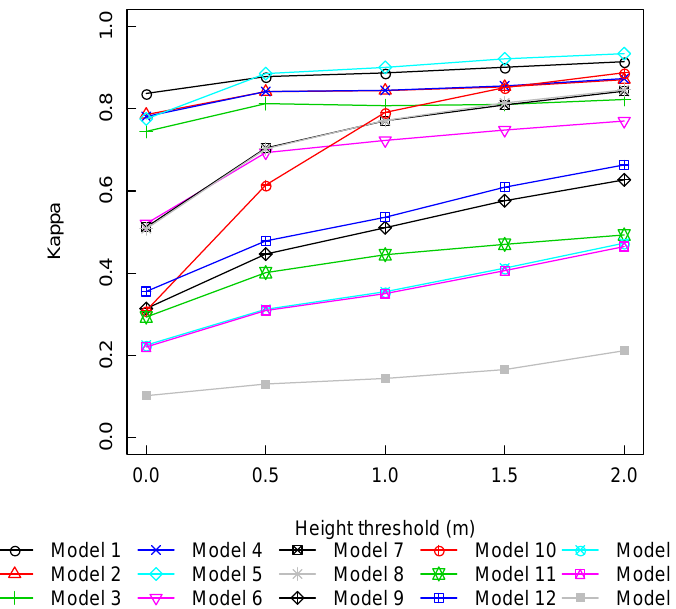
Figure 5. Classification accuracy (kappa) for all models at all height thresholds